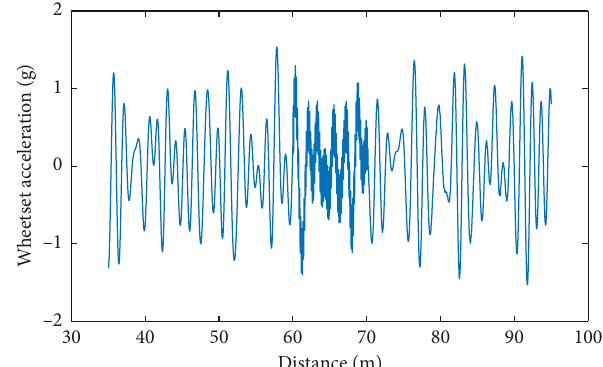
Figure 6: Vibration acceleration signal of wheel.